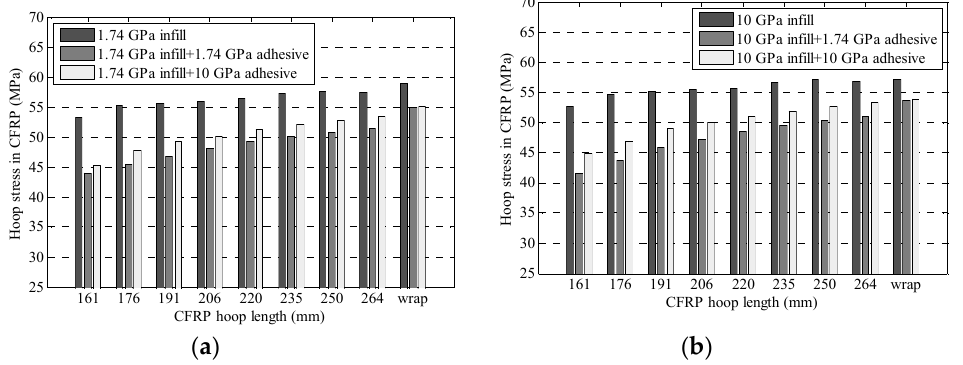
Figure 8. Effect of adhesive on hoop stress in pipe with infill material of ( a ) 1.74 GPa epoxy and ( b ) 10 GPa inorganic composite.